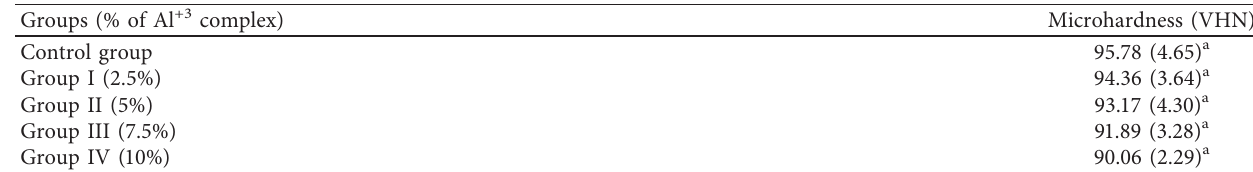
Table 4: Means and standard deviations (in parentheses) of Vickers microhardness of C-GIC and Al-GICs. Groups (% of Al +3 complex)